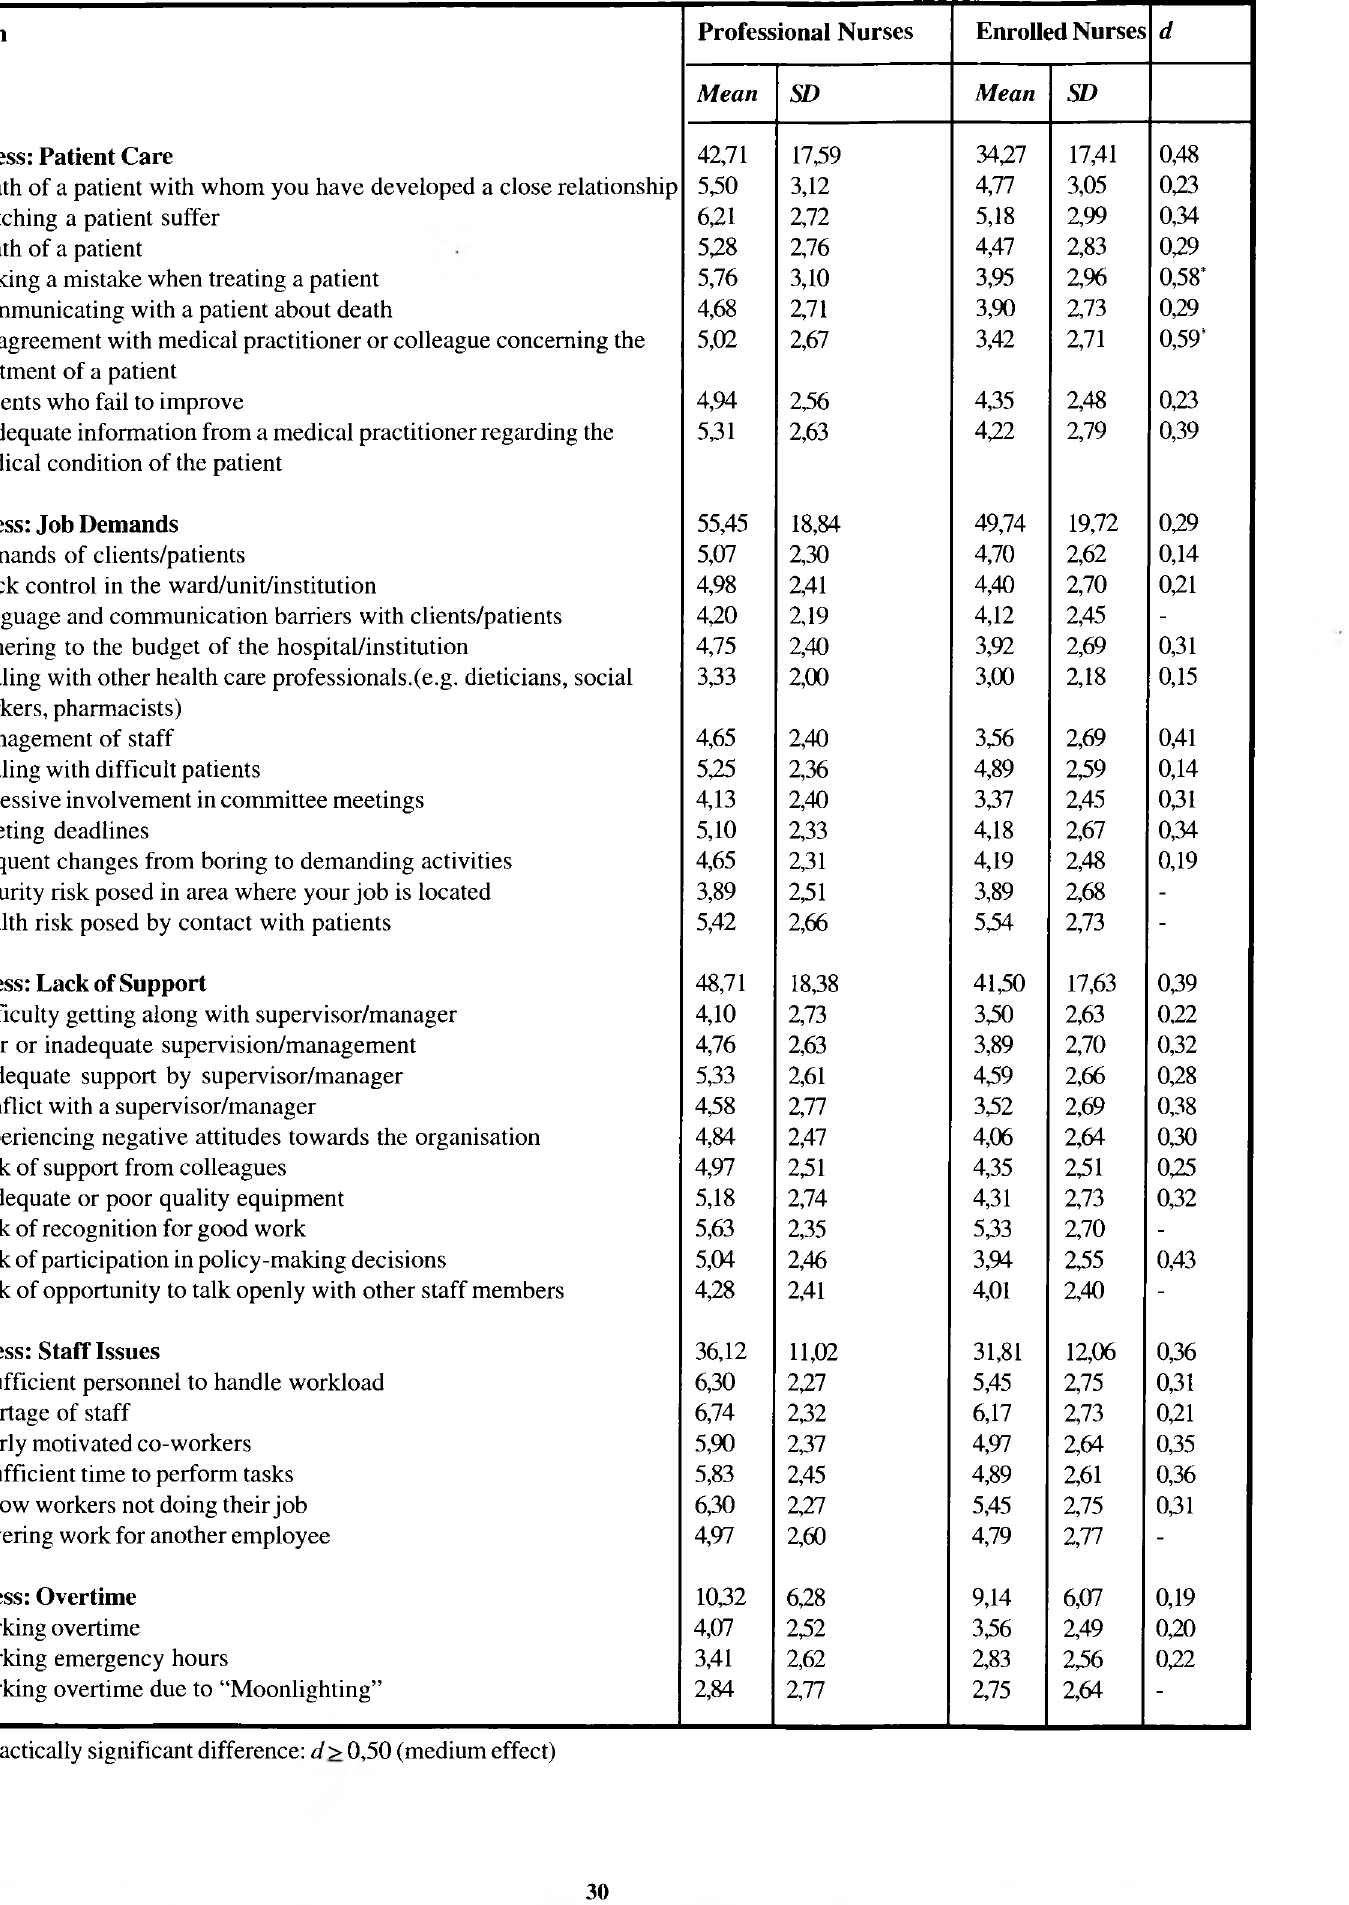
Item Professional Nurses Enrolled Nurses